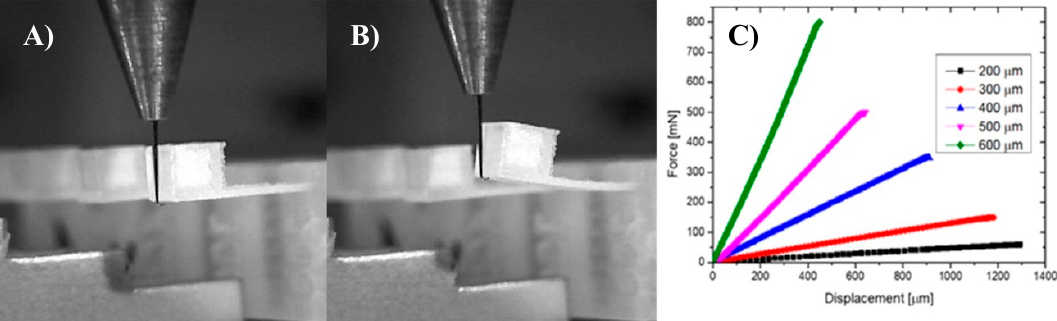
Figure 2. Characterization of microcantilevers: ( A ) non deflected, ( B ) fully deflected, ( C ) cantilever deflection vs bending force (cantilever length 4 mm and 2 mm